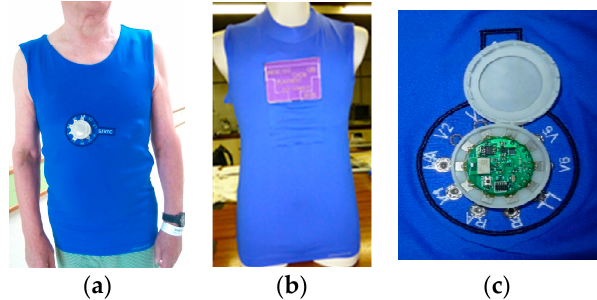
Figure 4. Photos of cardio surveillance T-shirts; ( a ) with embedded DAT unit; ( b ) with SFC for connection to a Holter monitoring device; and ( c ) photo of the DAT unit mounted in a custom designed socket.